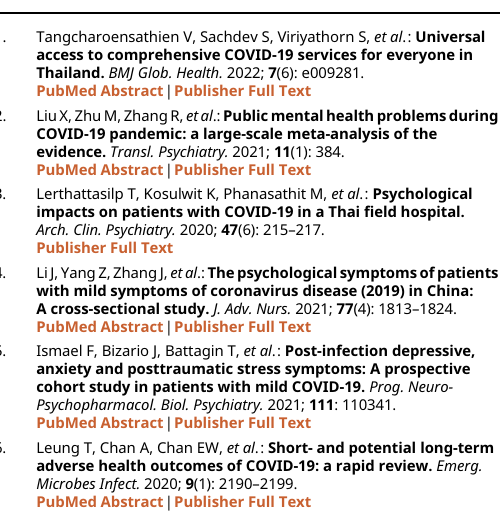
figshare: Mental health problems of asymptomatic or mildly symptomatic COVID-19 patients in hospitel in Thailand: A Cross-Sectional Study, https://doi.org/10.6084/m9.figshare.21108790.v1. 19 This project contains the following extended